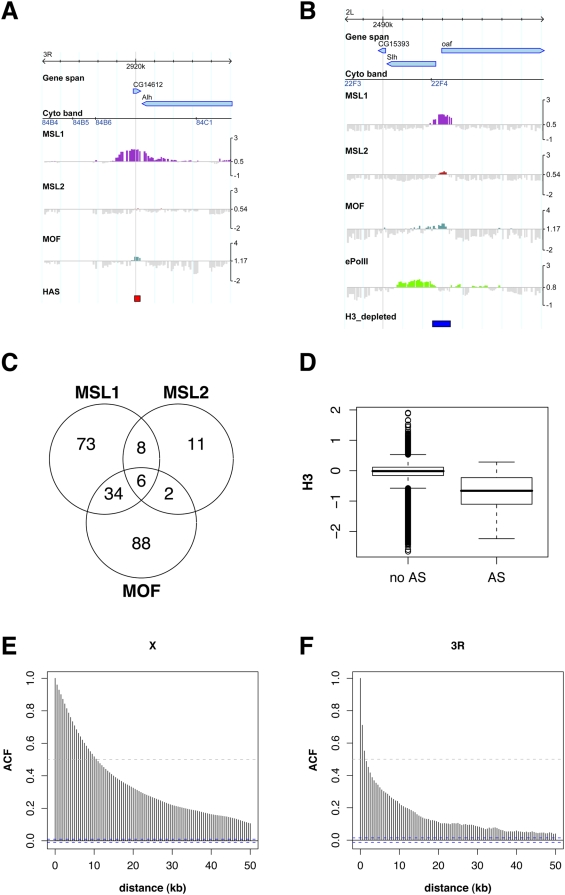
Autosomal binding sites of the DCC.A) Autosomal high affinity site. B) Autosomal site bound by MSL1, MSL2 and MOF. C) Venn diagram showing the colocalization of MSL1, MSL2 and MOF on autosomal binding sites. D) Boxplot comparing histone H3 signal on probes located on autosomal binding sites (AS) and probes located elsewhere on autosomes. E) Autocorrelation (ACF) of MSL1 binding to the X chromosome and (F) to chromosome 3R. Correlation was performed on smoothed profiles with 500 base spacing.